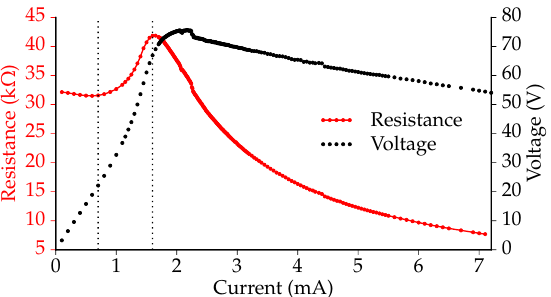
Figure 8. The measured resistance of and voltage over a sacrificial actuator (3 µm poly-Si thickness) as a function of the actuator current.